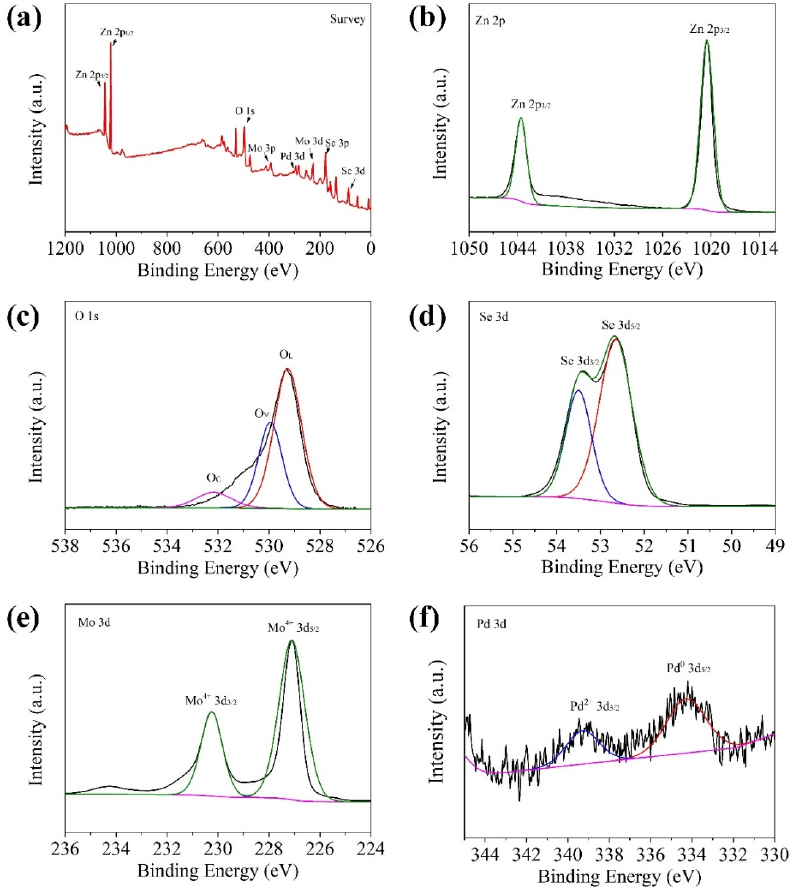
Figure 5. XPS spectra of Pd@ZnO/MoSe 2 sample: ( a ) full spectrum, ( b ) Zn 2p spectrum, ( c ) O 1s spectrum, ( d ) Se 3d spectrum, ( e ) Mo 3d spectrum and ( f ) Pd 3d spectrum.